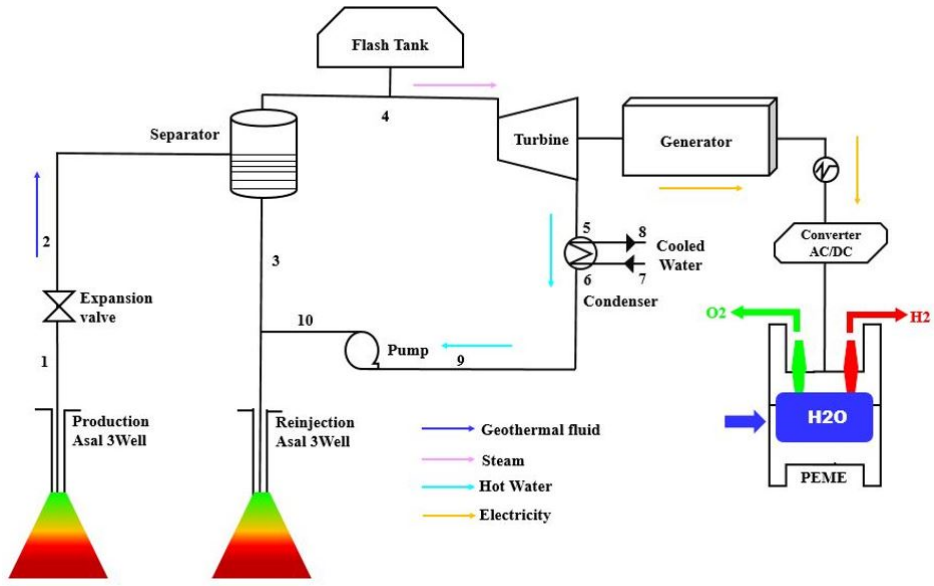
Figure 5. Schematic of the single flash cycle with electrolyzer for Asal-Ghoubbet hydrogen pro- duction.